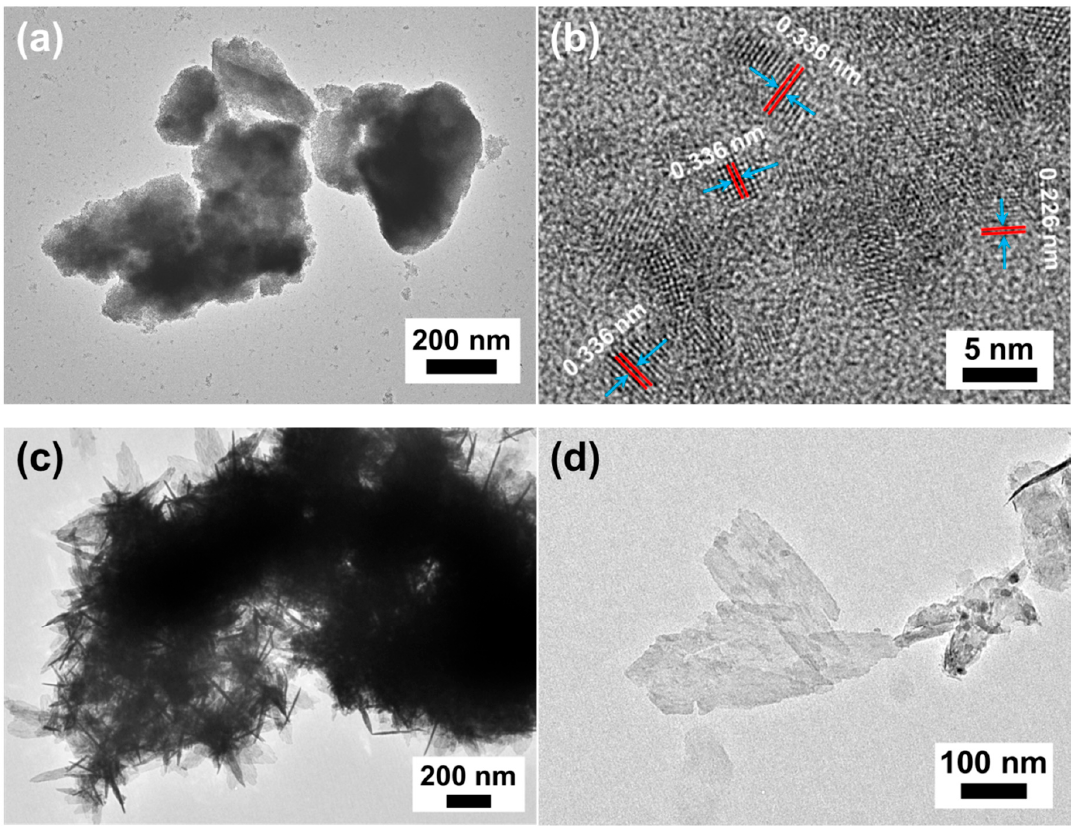
Figure 2. ( a ) TEM and ( b ) HRTEM images of synthesized SnO 2 NAs, and ( c , d ) TEM images of 3D structured SnO 2 NSs and random SnO 2 NSs.